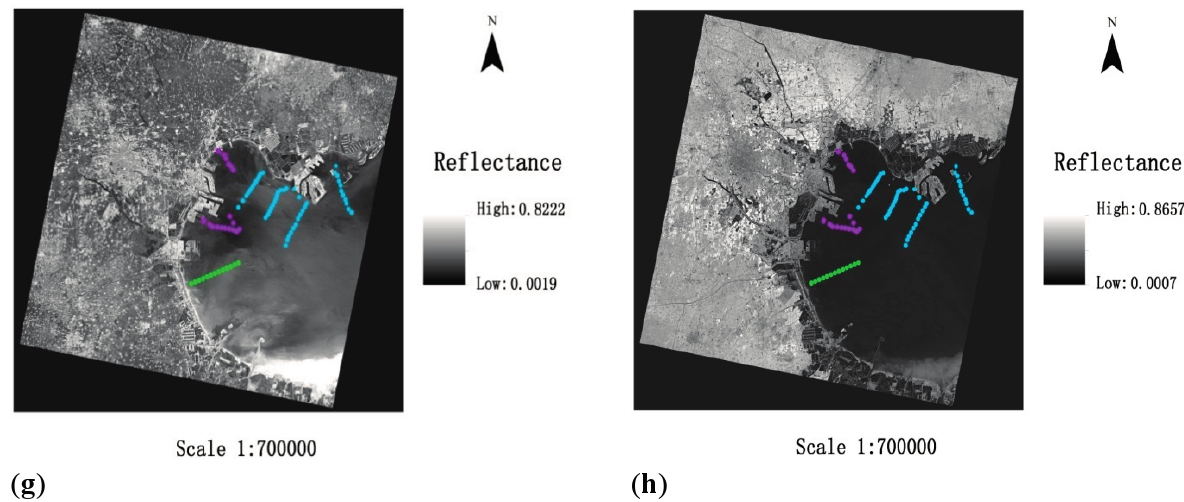
Figure 2. Landsat reflectance at bands 1 to 4 before ( a – d ) and after ( e – h ) the atmospheric correction. The atmospheric correction was completed using Fast Line-of-sight Atmospheric Analysis of Spectra Hypercubes (FLAASH), an atmospheric correction module in ENVI ® .